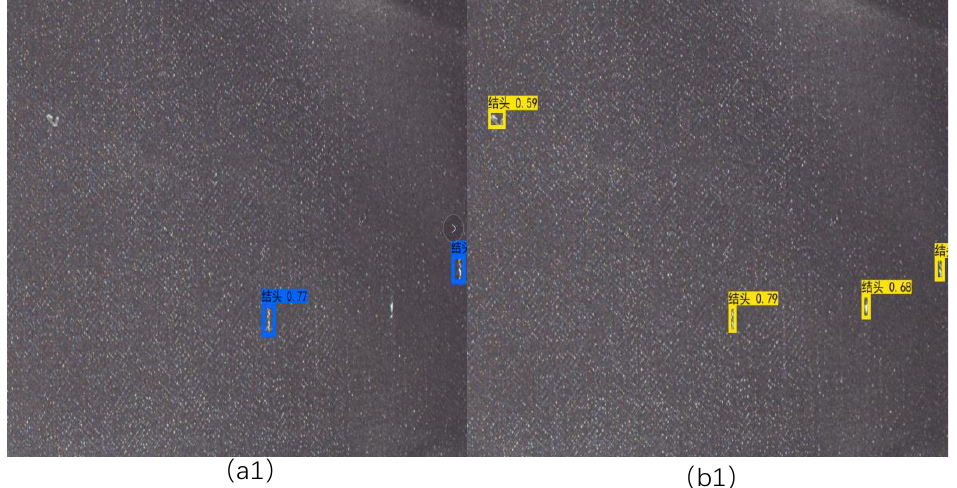
Figure 10. Experimental results of group1. ( a1 ) detection result of YOLOv4; ( b1 ) detection result of improved YOLOv4. Defect sizes are about 3 × 8 pixels.